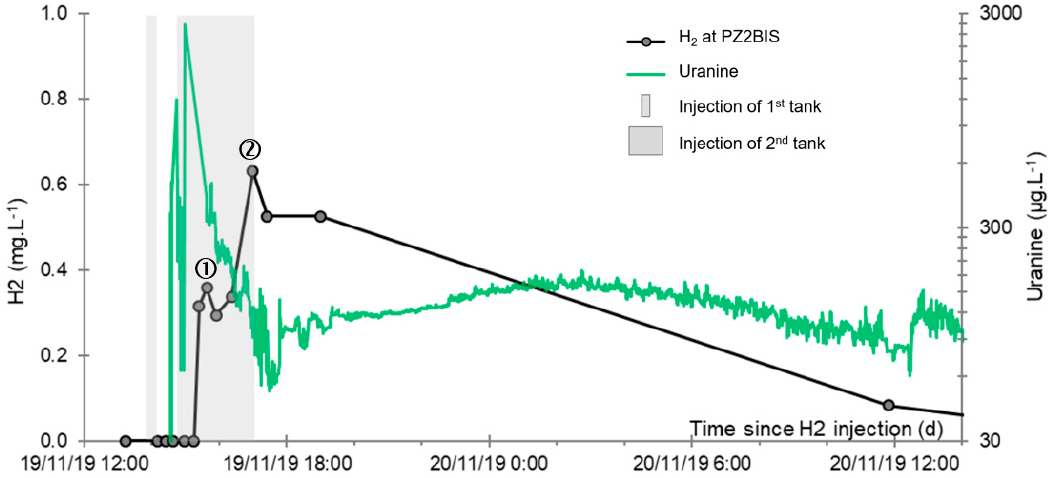
Figure 13. Detailed evolution of the dissolved H 2 and tracer concentration at PZ2BIS (5 m downstream) during the day of injection.